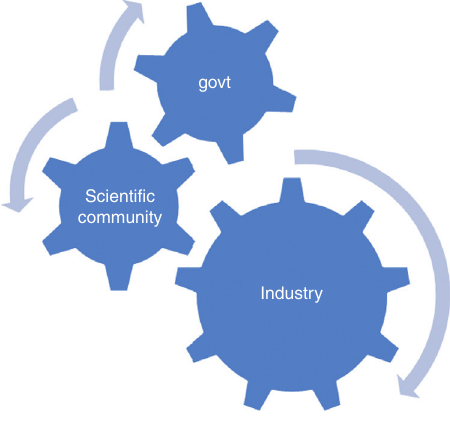
Figure 4 The nano-ST&I promotion